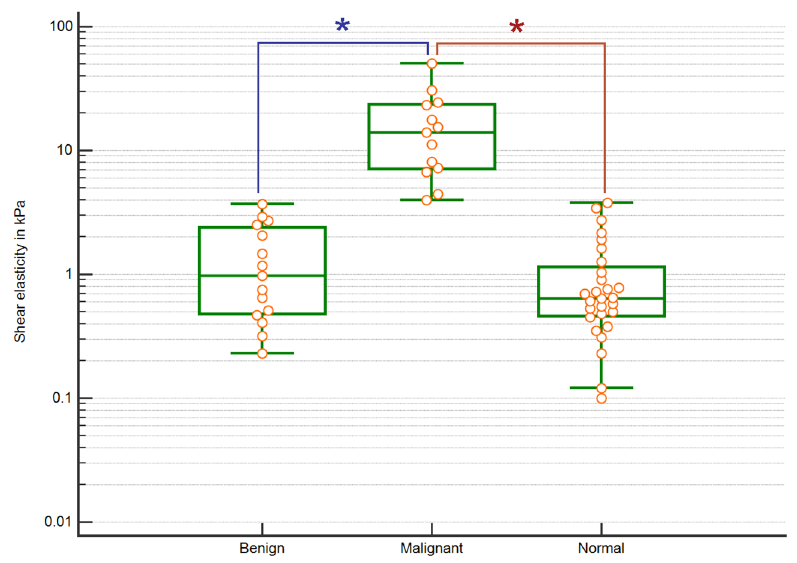
Fig 4. Box plot showing shear modulus distribution for benign masses, malignant masses and normal tissue estimated using a Voigt model with statistically significant differences marked.